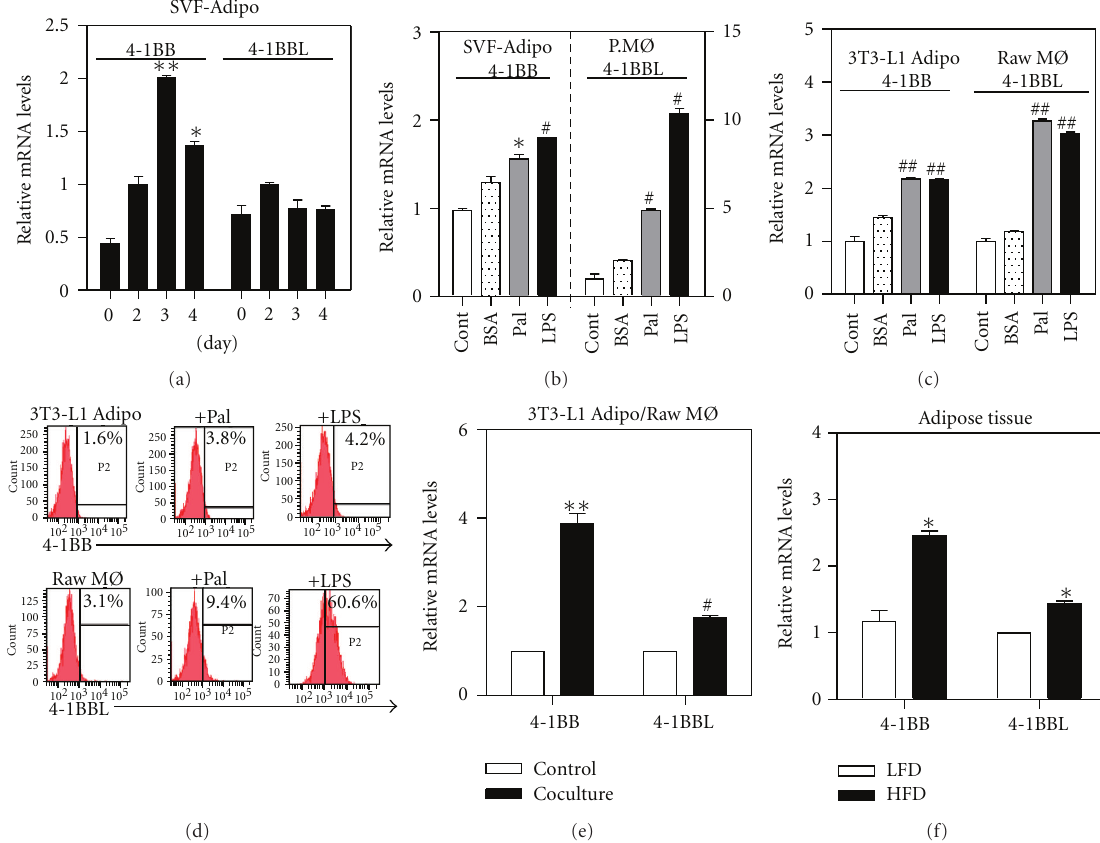
Figure 1: 4-1BB and 4-1BBL expression is upregulated by obesity-related factors in adipocytes and macrophages. 4-1BB and 4-1BBL mRNA expression in SVF-derived adipocytes (a) during adipogenesis. SVF-derived confluent preadipocytes (day 0) were di ff erentiated into adipocytes (days 2–4), as described in Section 2. 4-1BB and 4-1BBL mRNA levels in SVF-derived adipocytes and peritoneal macrophages treated with obesity-related factor (250 μ M Pal, 100 ng/mL LPS) for 24 and 4h (b). 4-1BB/4-1BBL mRNA (c) and protein expression (d) in 3T3-L1 adipocytes and Raw264.7 macrophages treated with obesity-related factor (250 μ M Pal, 100ng/mL LPS) for 24 h and 4h. mRNA was measured by qRT-PCR, and protein levels were detected by FACS. 4-1BB and 4-1BBL mRNA levels in 3T3-L1 adipocytes/Raw264.7 macrophages cocultured for 24h (e), control indicates mixed adipocytes/macrophages, which were cultured separately for 24 h and mixed after harvest, and in the epididymal adipose tissue (f) of mice fed a high-fat diet (HFD) or low-fat diet (LFD) ( n = 4 mice per group). Levels of mRNA were estimated by qRT-PCR. Pal, palmitic acid; Adipo, adipocytes; P.MØ, peritoneal macrophages; Raw MØ, Raw264.7 macrophages. Data are the mean ± SEM of three independent experiments performed in duplicate. ∗ P < 0 . 05; ∗∗ P < 0 . 01; # P < 0 . 005; ## P < 0 . 001 (compared with